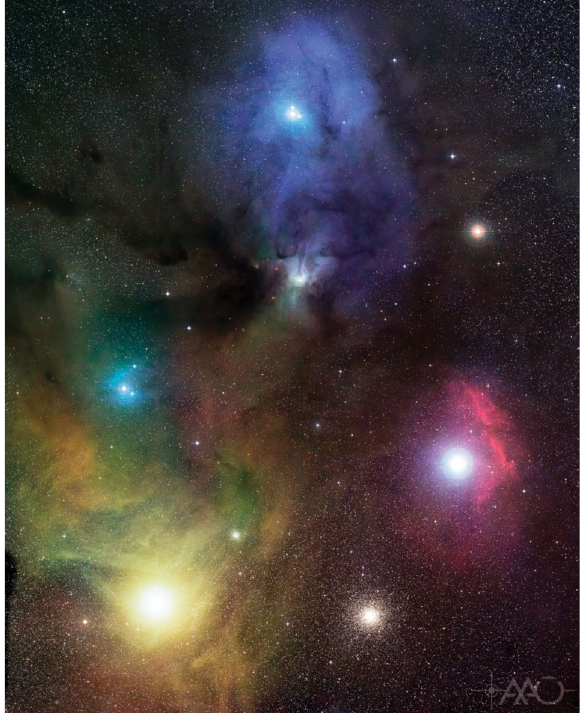
FIG. 7. Antares and the Rho Ophiuchi dark cloud. One of the early works of David Malin, combining black and white astronomical images (glass negatives), taken in different filters. Image credit: David Malin/AAO/UKS